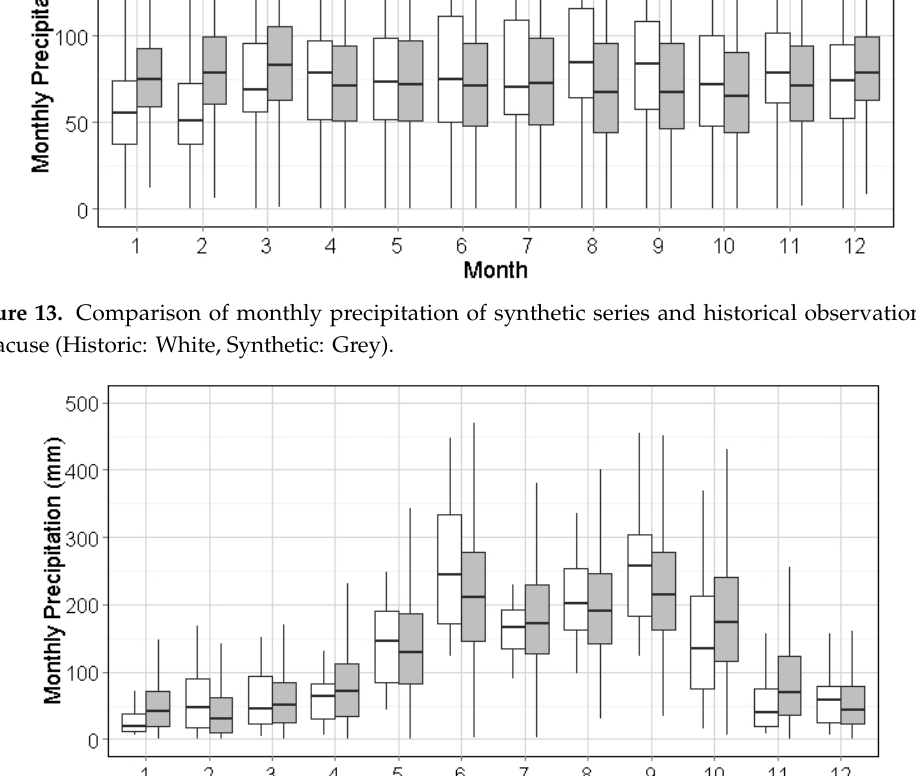
Figure 14. Comparison of monthly precipitation of synthetic series and historical observations in Miami (Historic: White, Synthetic: Grey).